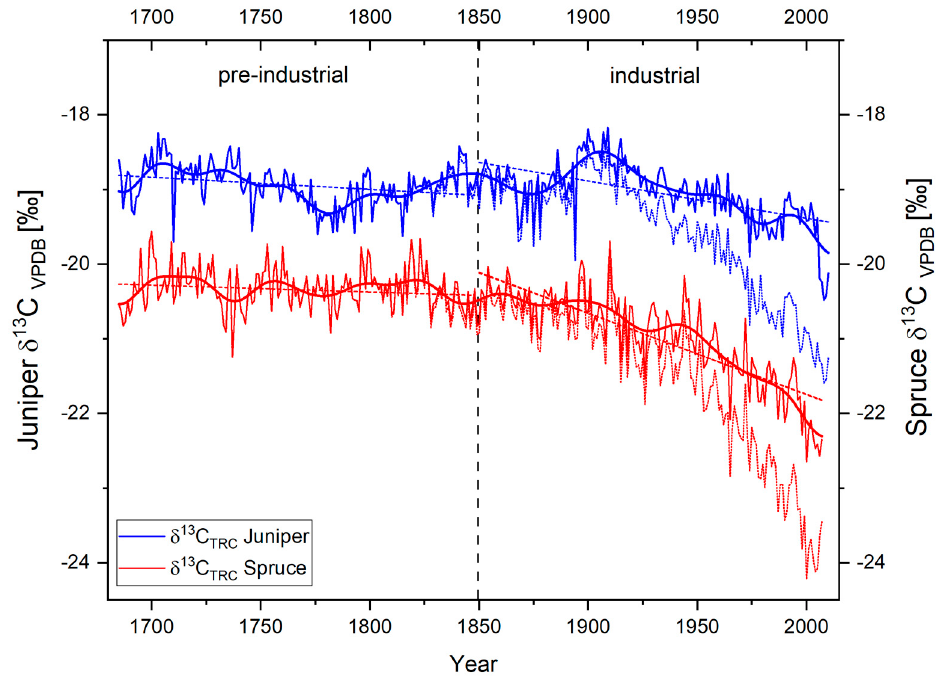
Figure 4. Annual δ 13 C TRC variations of Juniperus tibetica (blue) and Picea balfouriana (red) at Qamdo for the period 1685 − 2011. Bold lines represent δ 13 C TRC CO 2 -corrected series and associated 11-year Fast Fourier Transform (FFT) filters, bright dotted time series indicate the species specific uncorrected δ 13 C TRC raw series, and dotted lines represent species-specific linear trends of the corrected series over the pre-industrial (1685 − 1849) and industrial period (1850 − 2007), respectively.